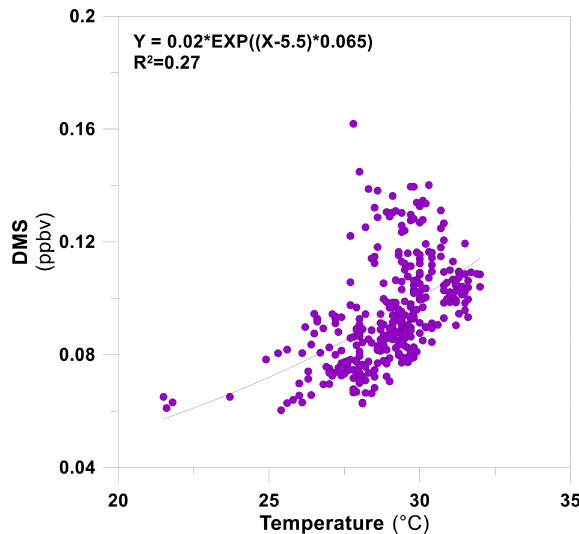
Figure 7. Daytime DMS mixing ratios from the western sector (ma- rine source) as a function of the temperature along the measurement campaign. An exponential fit between the two is